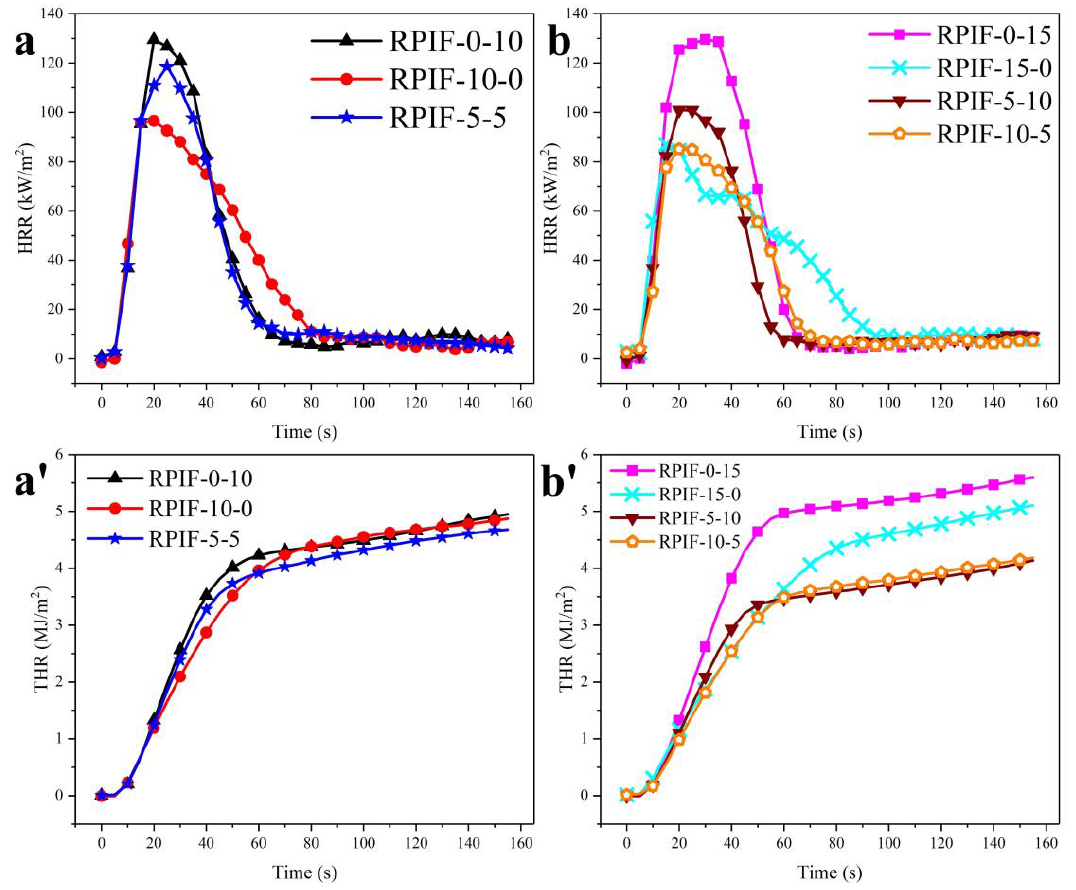
Figure 8. HRR and THR curves of RPIF with total dosages of EG and PPCP at 10 wt. % ( a , a′ ) and 15 wt. % ( b , b′ ).